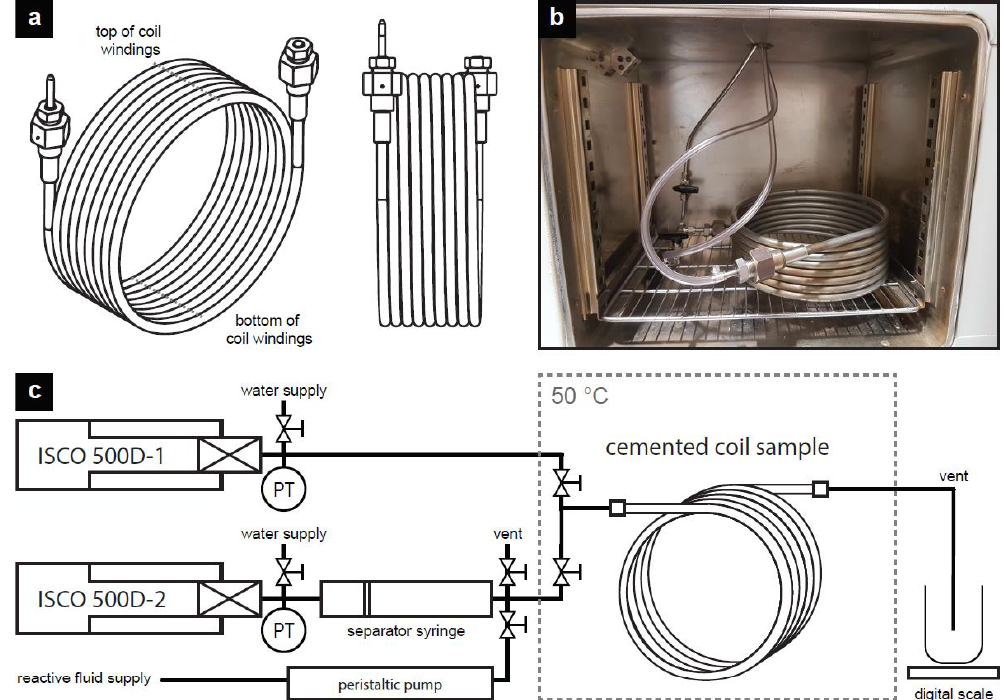
Figure 1. Sample design and experimental setup; ( a ) schematic drawing of a cemented steel tube coil sample, where the top and bottom of the coil windings during cement curing are indicated. Note post-experimental cross-sections were obtained from these locations; ( b ) photograph of sample SIL-1 mounted inside the permeameter setup, ( c ) schematic illustration of the experimental permeameter setup, where PT denotes pressure transducer. See main text for detailed descriptions.